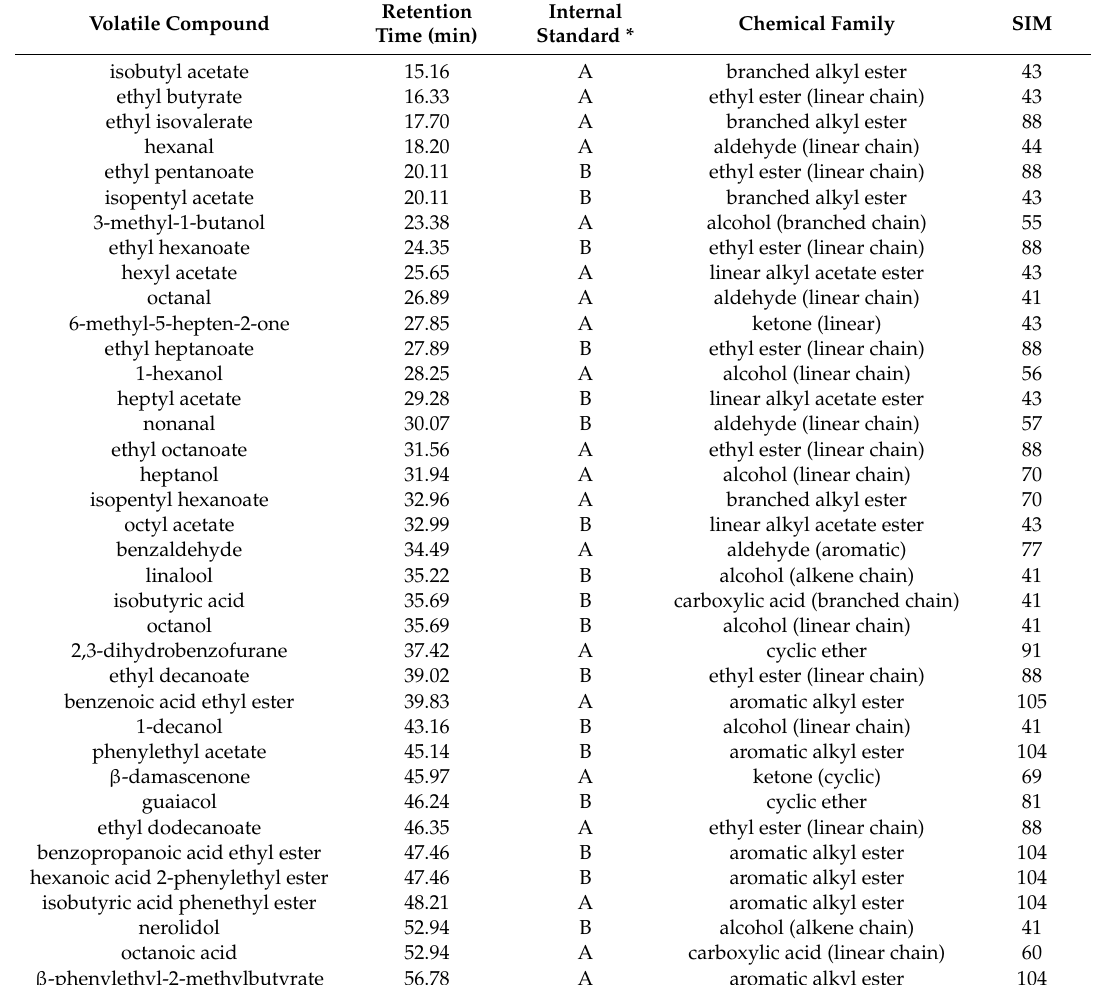
Table 1. Volatile compounds studied, retention times, internal standard employed, chemical family and MS fragment employed for the